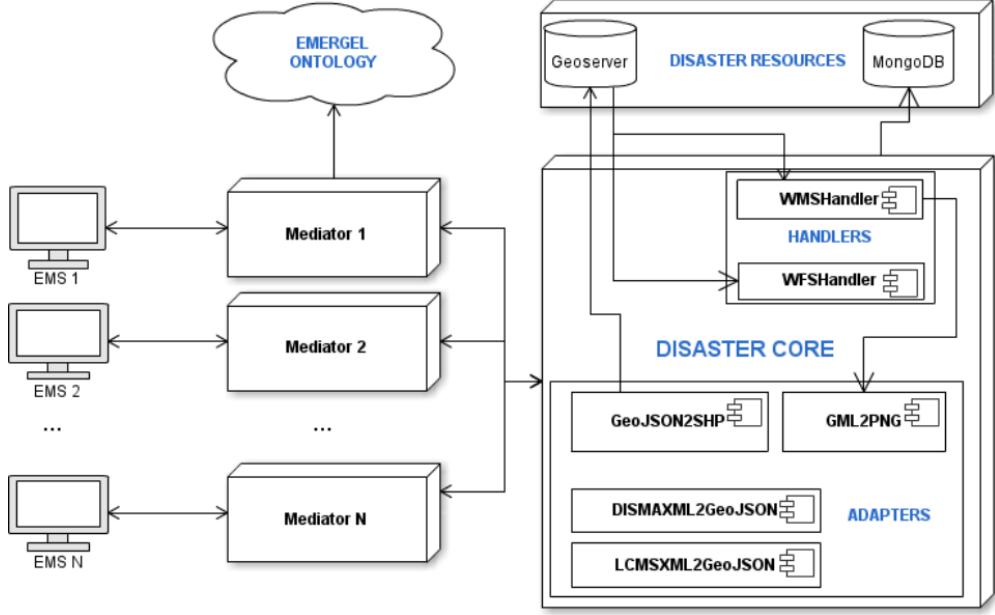
Figure 4. DISASTER software technical architecture. The DISASTER core is the kernel of the proposed technical solution. It provides a set of functionality to the mediators making their implementation easier and uniform. A DISASTER Mediator is a gateway between a concrete EMS and the rest of the existing resources. Input mediators allow an EMS to consume external resources adapted to each one’s own style. Output mediators allow sharing information to other